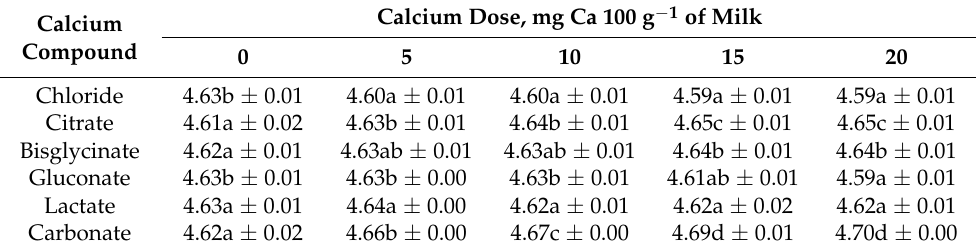
Table 3. pH of acid rennet goat’s milk gels. Calcium Compound